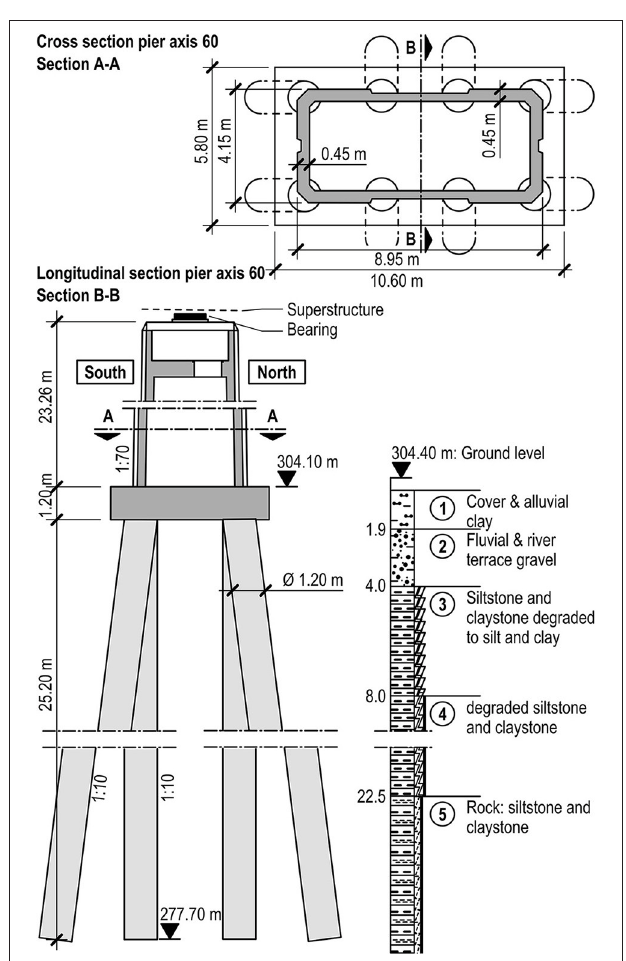
FIGURE 3 | Geometry and dimensions of the pier and foundation and characteristics of the soil at axis 60 (Wenner et al., 2019).